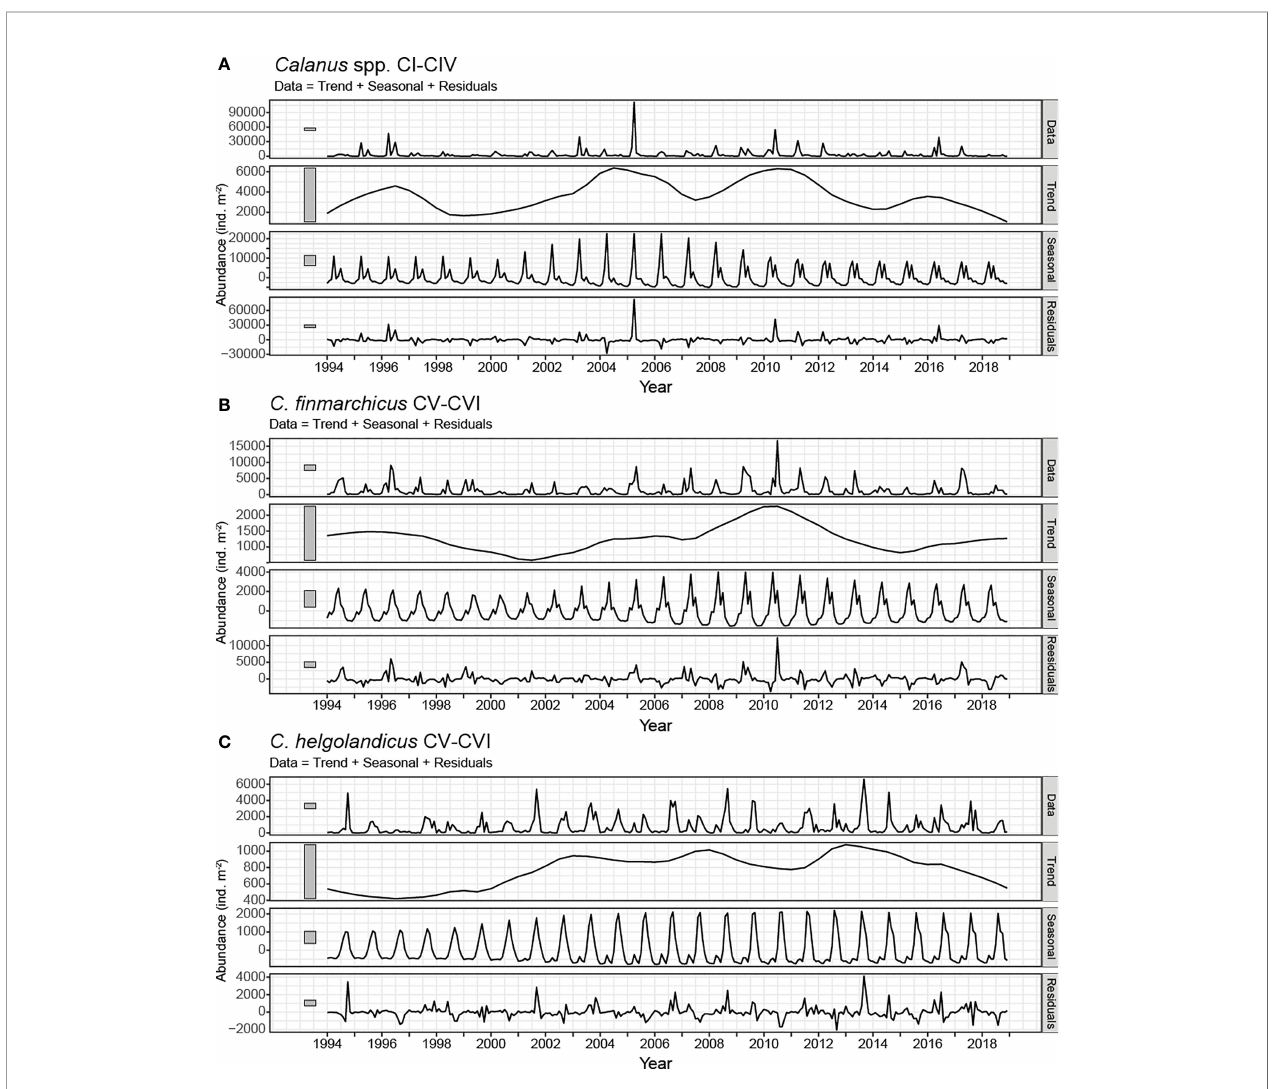
FIGURE 5 | Seasonal and Trend time series decomposition using Loess with a 5-year trend window and 12-month seasonal window for the abundance of (A) Calanus spp. CI-IV, (B) C. fi nmarchicus CV-VI and (C) C. helgolandicus CV-VI. For each of the three time series shown (A – C) , fi ve sub-panels are presented. Original data are presented in the uppermost panels as monthly average abundances (Data). The Loess trend-cycle component (Trend) captures the interannual variability. The seasonal component (Season) shows the within-year variability throughout time. In the lowermost panel for each time series, the component representing the remainder is shown (Residuals), which is what is left after subtraction of the seasonal and the trend/cycle components from the original monthly abundances. Grey bars to the left of each panel show the relative scales of contribution of each